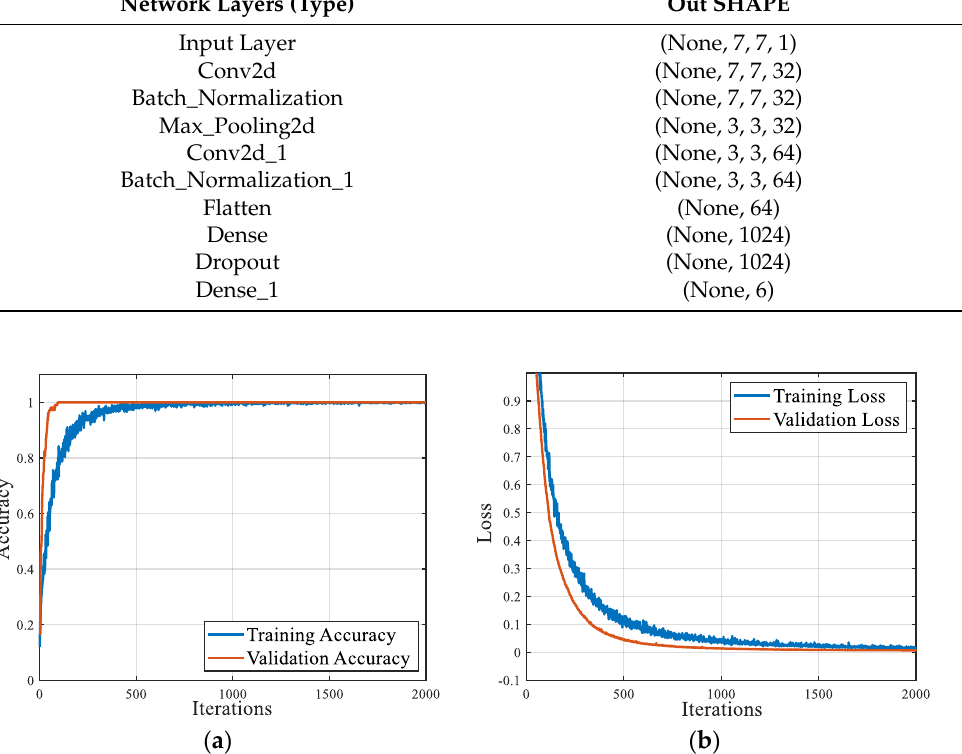
Figure 7. ( a ) The accuracy of training set and validation set; ( b ) The loss function of training set and validation